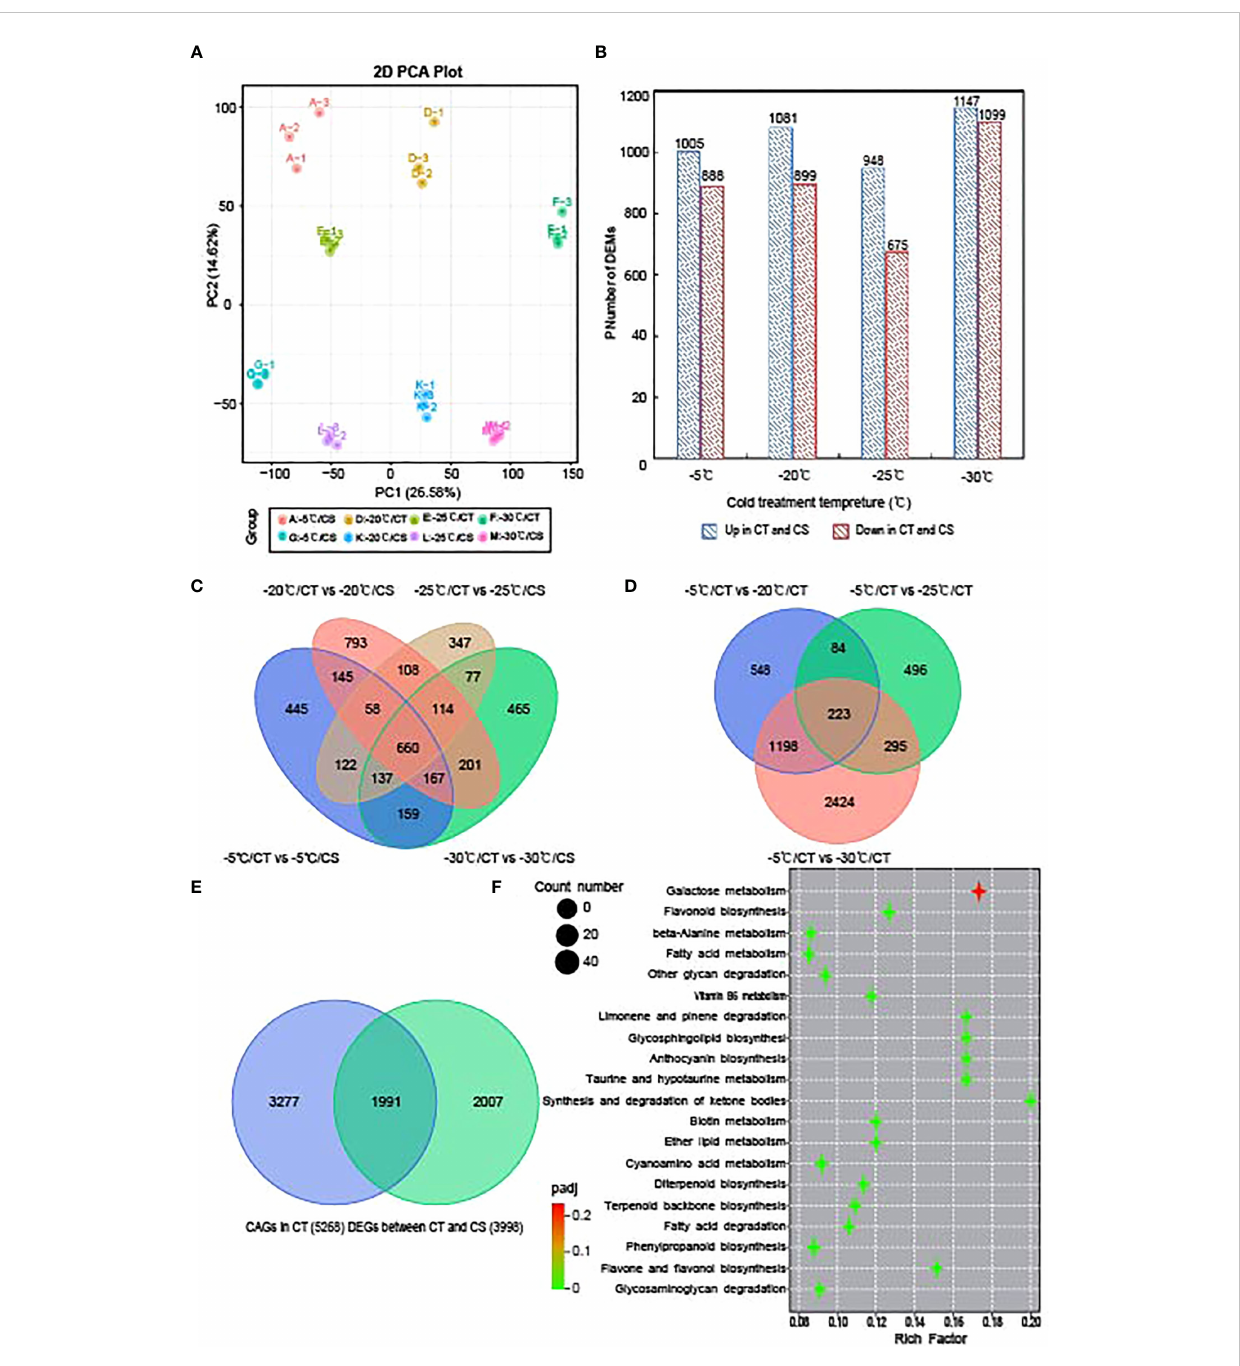
FIGURE 3 Transcriptome analysis of CT and CS under cold stress. (A) PCA of the gene expression pro fi les of CT and CS under cold stress. (B) Numbers of DEGs in in CT compared to CS under different temperatures. (C) Venn diagram of DEGs in CT compared to CS under different temperatures. (D) Venn diagram of DEGs in CT under chilling stress (-20°C, -25°C and -30°C) relative to control (-5°C). (E) Venn diagram of DEGs identi fi ed in CT and CS under chilling stress (-20°C, -25°C and -30°C) compared to control (-5°C). Blue: CT; green: CS. (F) KEGG pathway of the commonly deregulated genes in CT and CS under